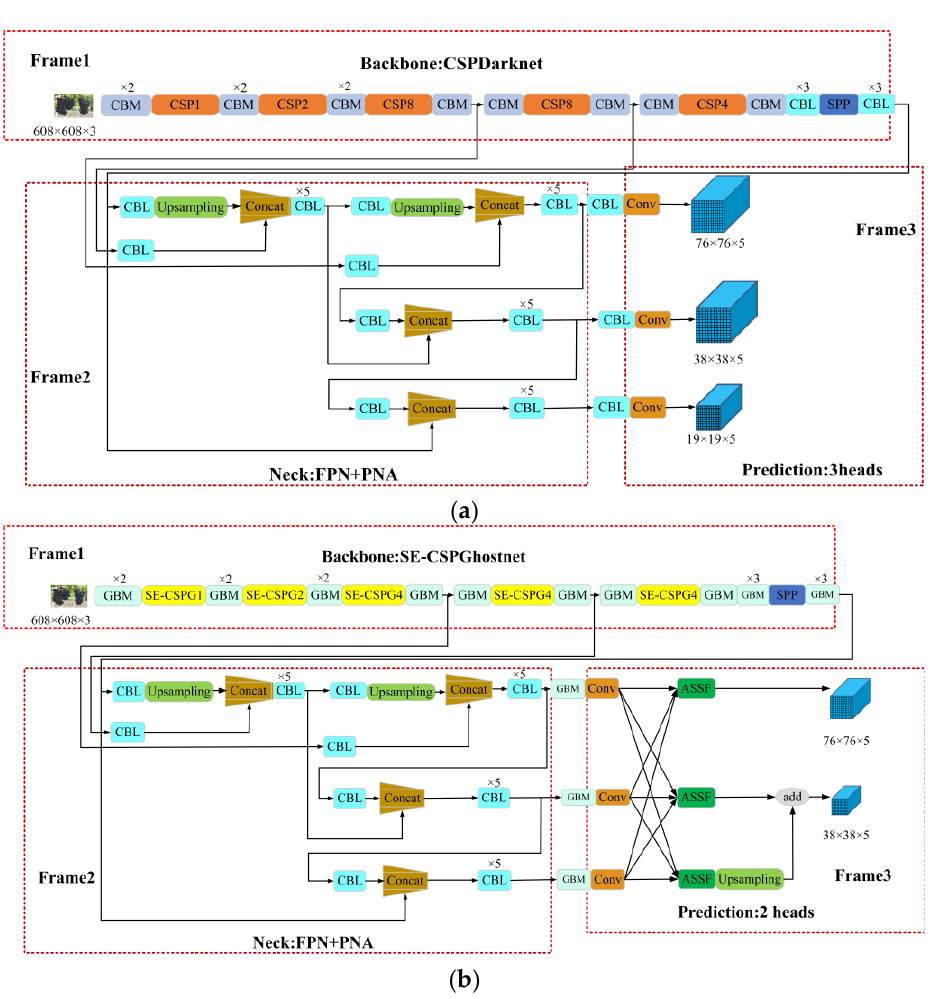
Figure 5. ( a ) YOLOV4 network model structure ( b ) GA-YOLO network model structure.